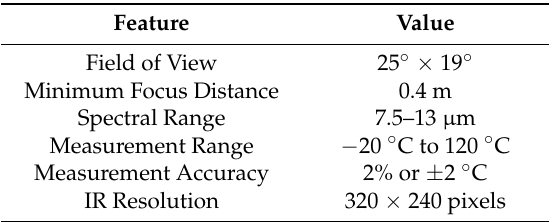
Table 1. FLIR B425 Equipment